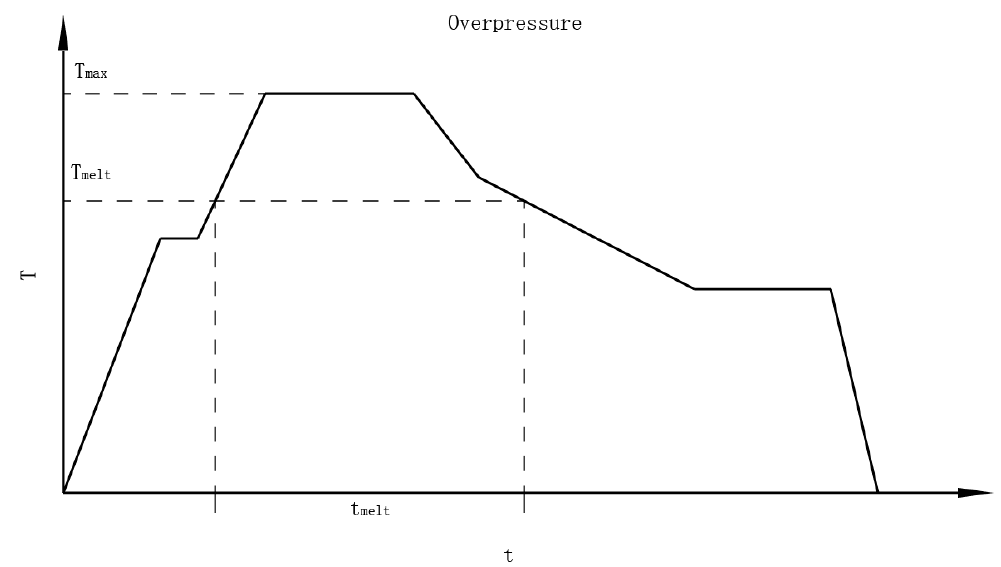
Figure 5. Heat treatment schedule for Bi-2212 wires. T max is the maximum temperature and T melt is the melting point of the Bi-2212 filaments. The time it takes for Bi-2212 filaments to melt is called t melt .